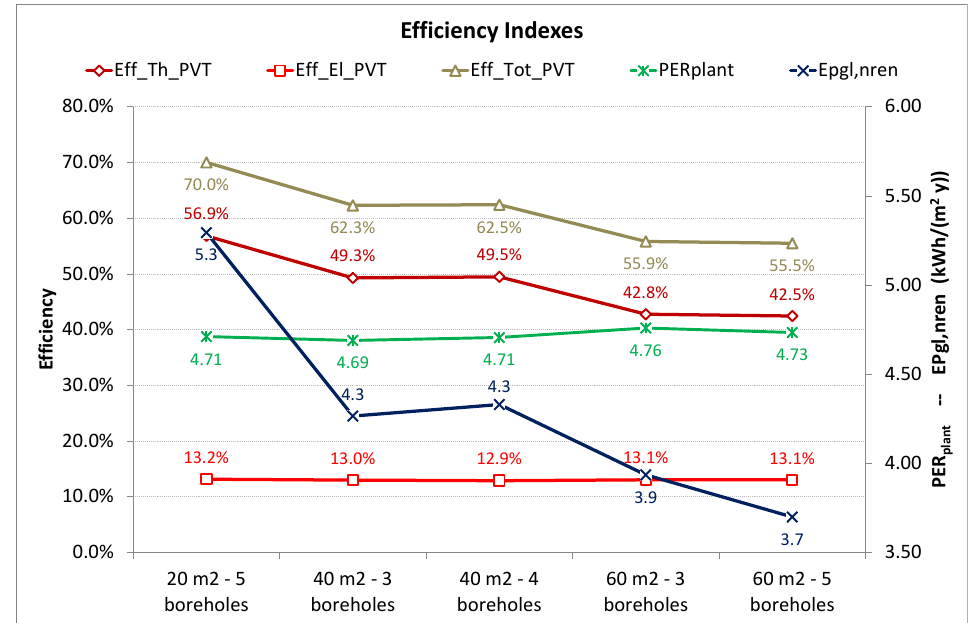
Figure 13. Annual values of the thermal, electric, and total efficiency of the PVT plant, PER of the whole plant, and the specific non-renewable primary energy consumption.